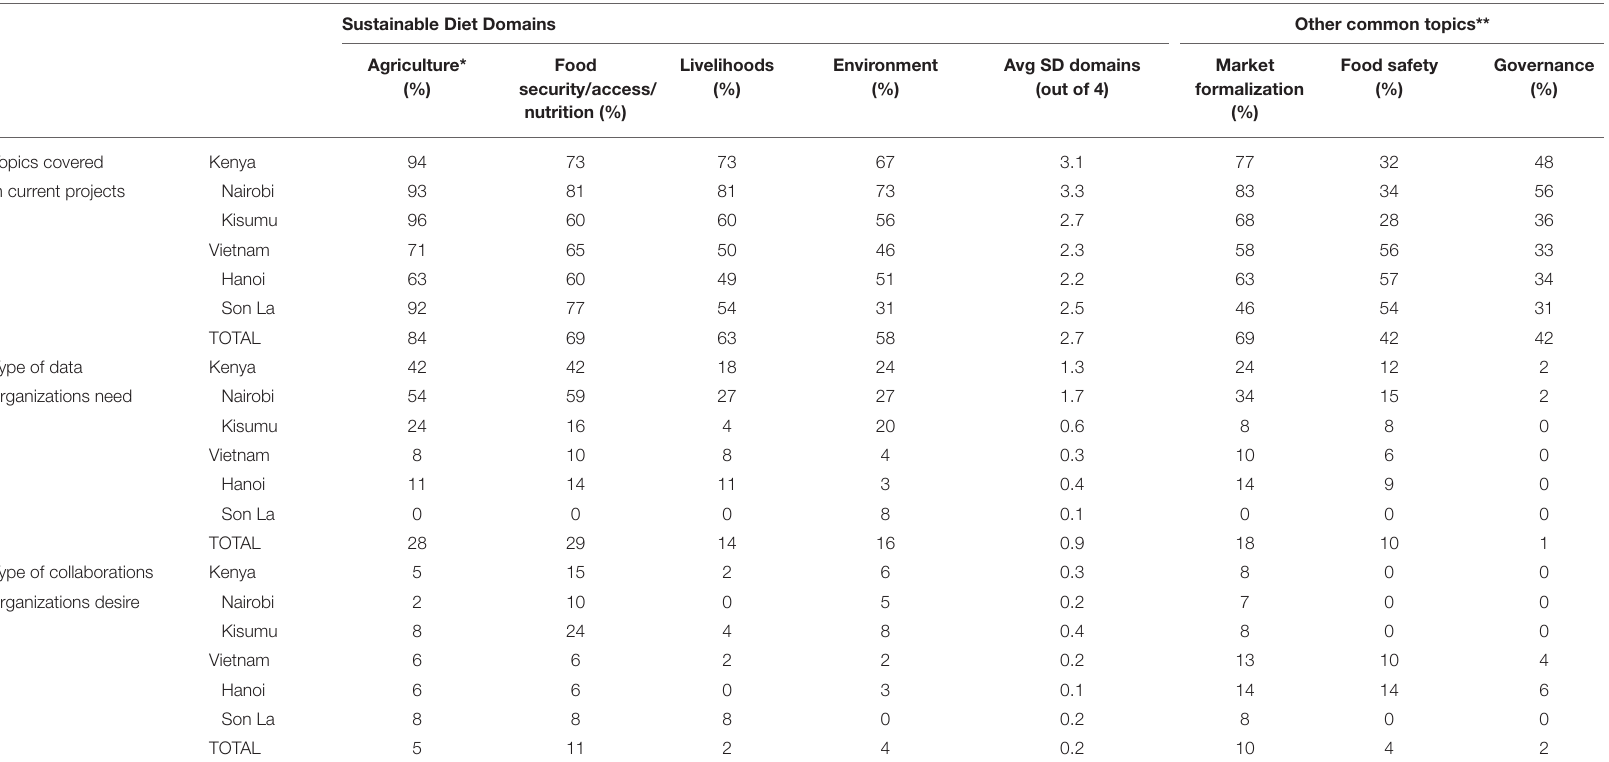
TABLE 3 | Percentage of organizations that cover sustainable diet domains and other topics in current projects, and domains and topics associated with needed data and collaborations, by country and geographic